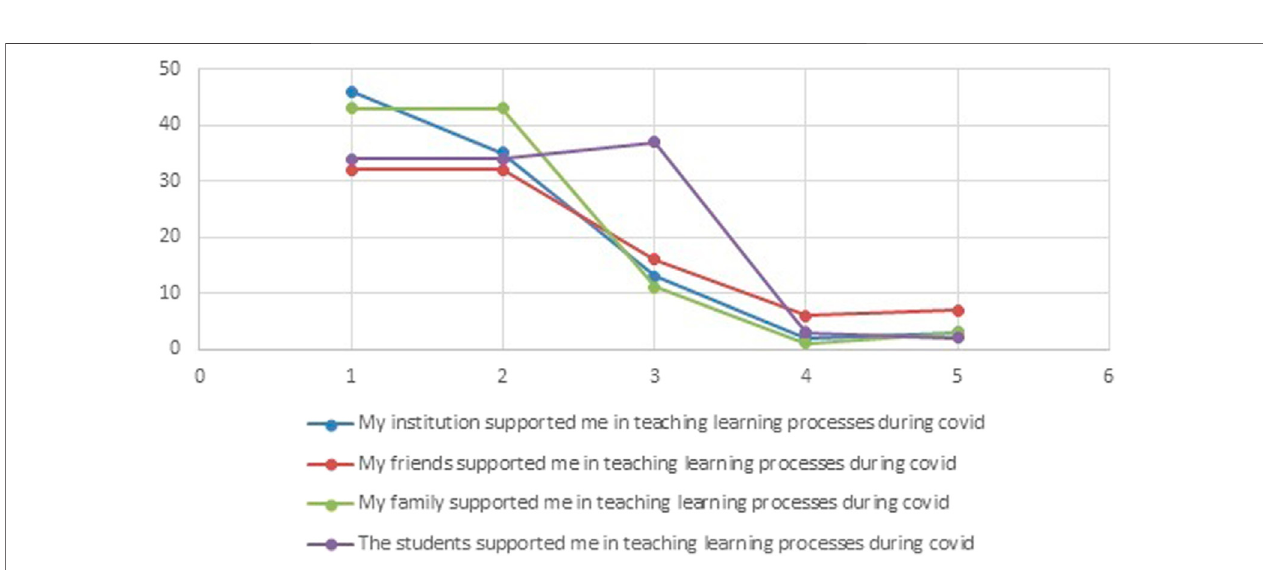
FIGURE 3 | External